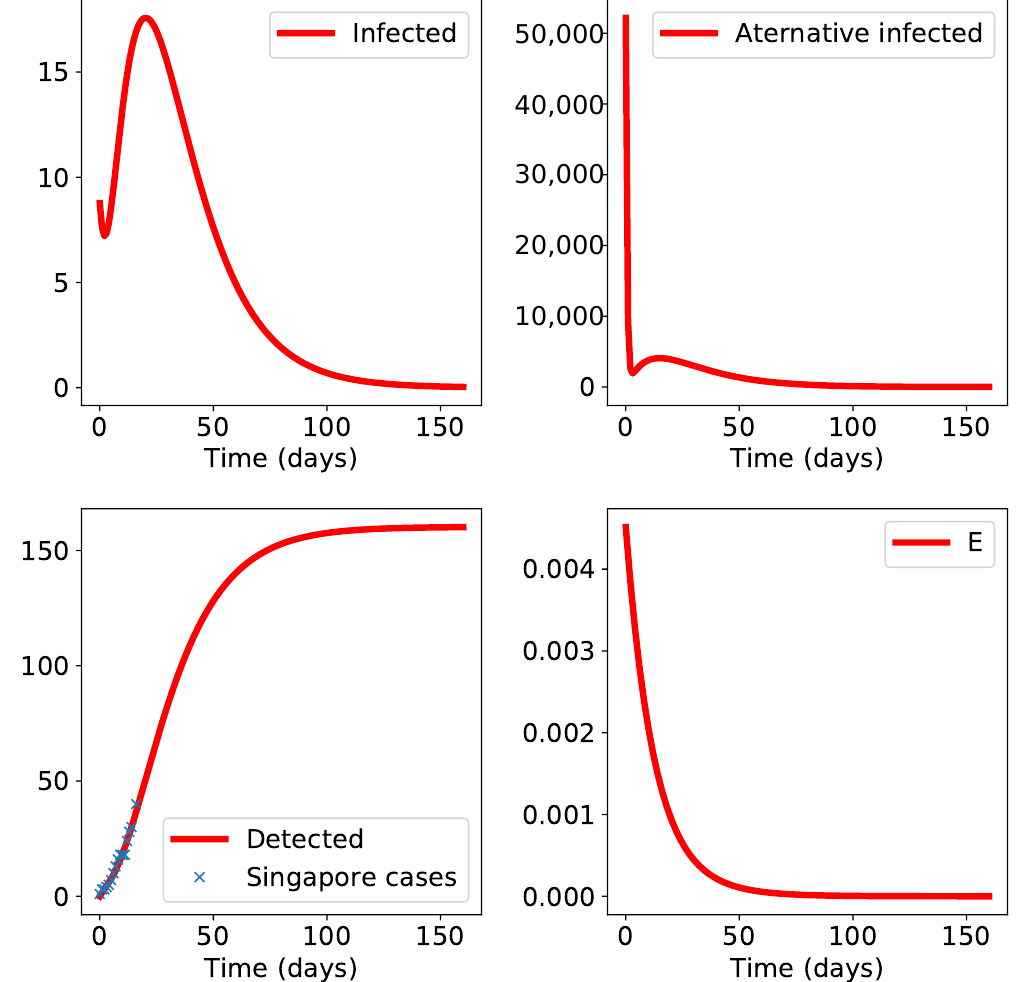
Figure 6. Simulation results for Singapore. The initial time t 0 is set to 23rd January. The class “E” is small and decreasing which indicates negligible environmental